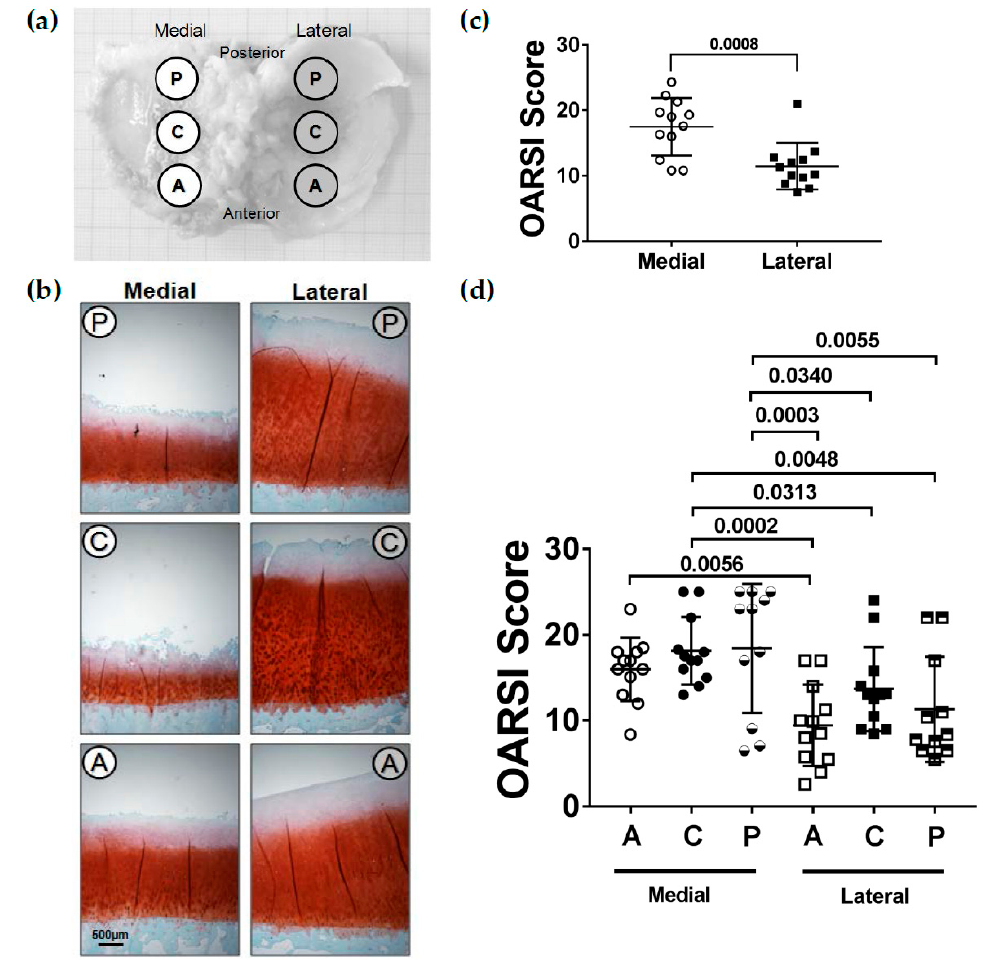
Figure 1. Histopathological Osteoarthritis Research Society International (OARSI) score of the articular cartilage from the medial and lateral tibial compartments. ( a ) Schematic figure depicting the different subregions at which osteochondral plugs were harvested (A: anterior, C: central, P: posterior). ( b ) Representative Safranin O/Fast green-stained sections of the different subregions. ( c ) Total OARSI score determined for the medial and lateral tibial compartments ( n = 12). ( d ) Total OARSI score determined for the different subregions (A: anterior, C: central, P: posterior) at the medial and lateral tibial compartments ( n = 11–12 per subregion). Values are represented as scatter plots with indicated mean. Significance between medial and lateral tibial plateaus was evaluated using the paired t -test and between subregions using the ANOVA with repeated measurements and Duncan’s multiple range test for post-hoc analysis.